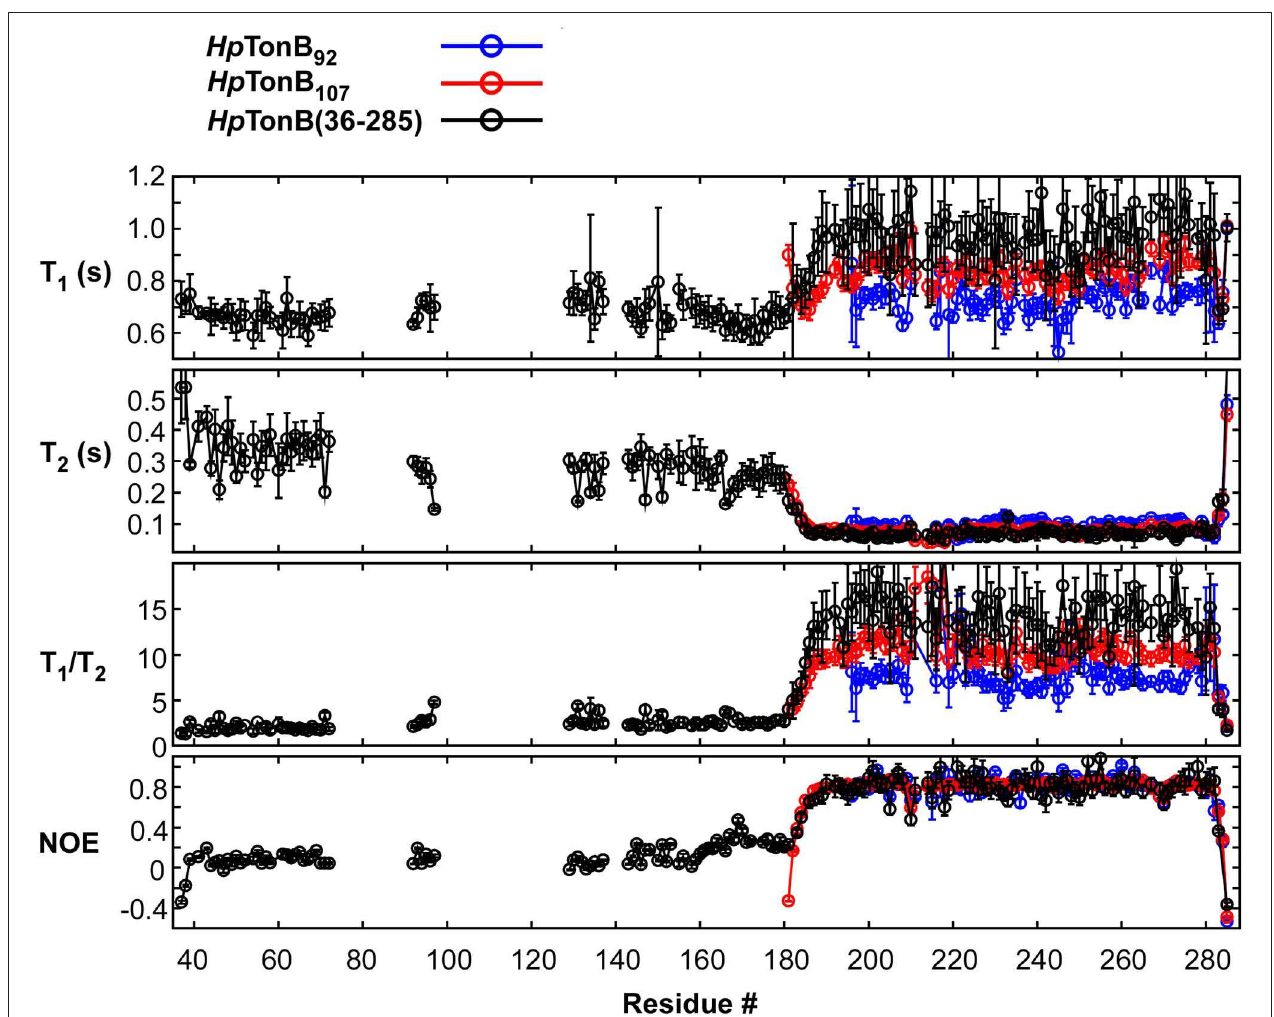
FIGURE 6 | 15 N relaxation data obtained for Hp TonB 92 , Hp TonB 107 , and Hp TonB (36–285) are shown in blue, red, and black, respectively. The longitudinal relaxation time (T 1 ), transverse relaxation time (T 2 ), T 1 /T 2 ratios, and heteronuclear 15 N{ 1 H}-NOE are plotted against the residue number. Residues with overlaps and residues with ambiguous assignments were removed from the